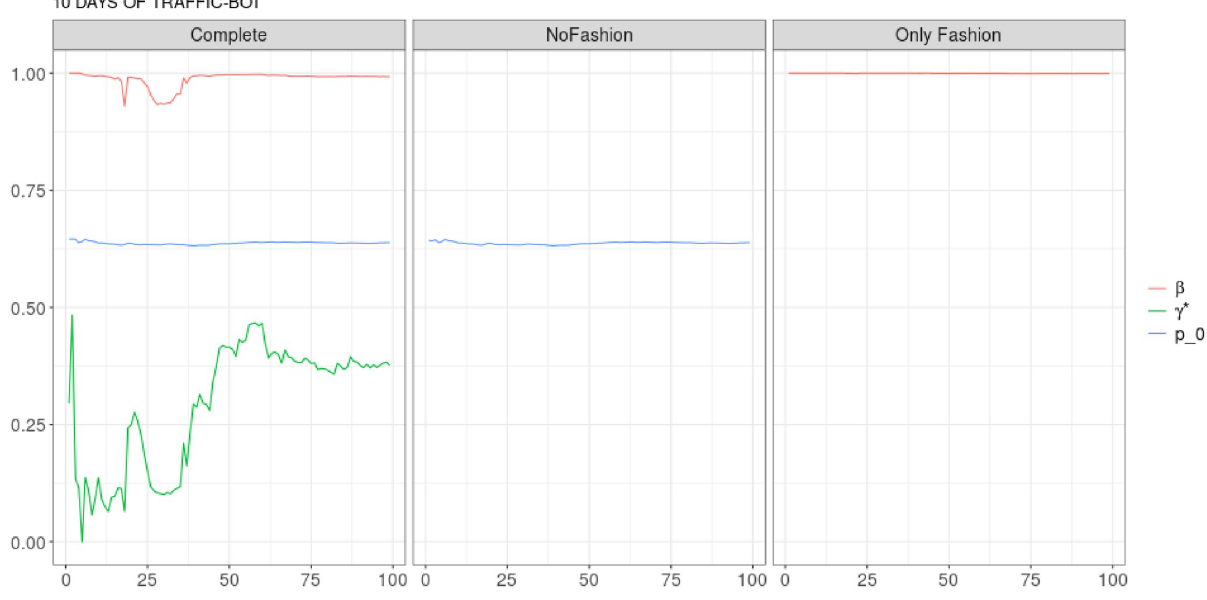
Fig 10. “10 days of traffic” ( T = 0.35, only BOTs’ posts, D = 30 00 ): Model parameters evolution with S = 100 slots of equal size (i.e. 1023 observations). Every parameter of the complete model, but γ � , are essentially constant. Let us remark that γ � tunes the weight of the fashion process in the predictive